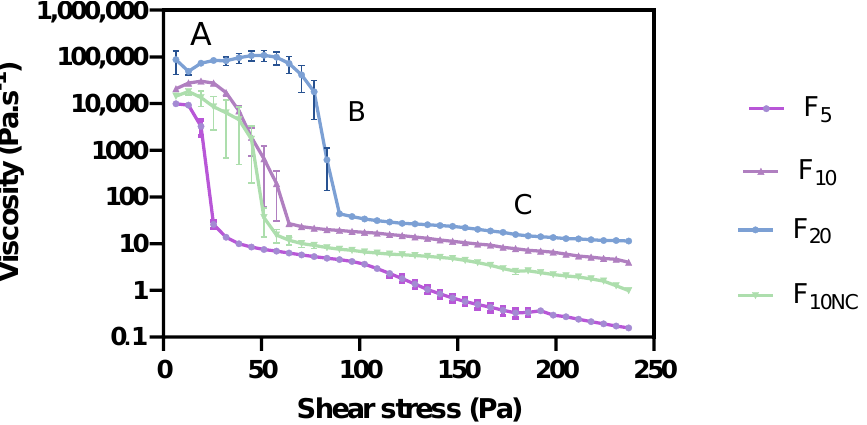
Figure 2. Effect of glycerol monostearate content (F 5 , F 10 and F 20 ) and homogenization rate (F 10NC ) on formulation viscosity curve. ( A ): 1st Newtonian plateau; ( B ): Shear-thinning range; ( C ): 2nd Newtonian plateau. Results report to a 6 < n < 12.